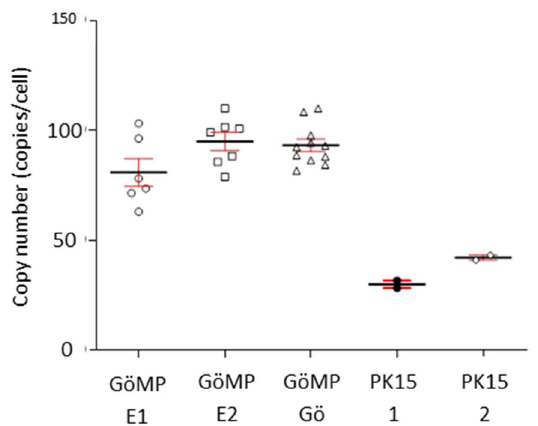
Figure 5. Determination of the copy number of PERV in the genome of Göttingen Minipigs (GöMP) from Ellegaard (E) and from the University of Göttingen (Gö) using GAPDH as reference. In addition, PK15 cells were tested. Results under number one (1) were published in Fiebig et al. [10], number two (2) represent data obtained in this study together with the testing of GöMP from